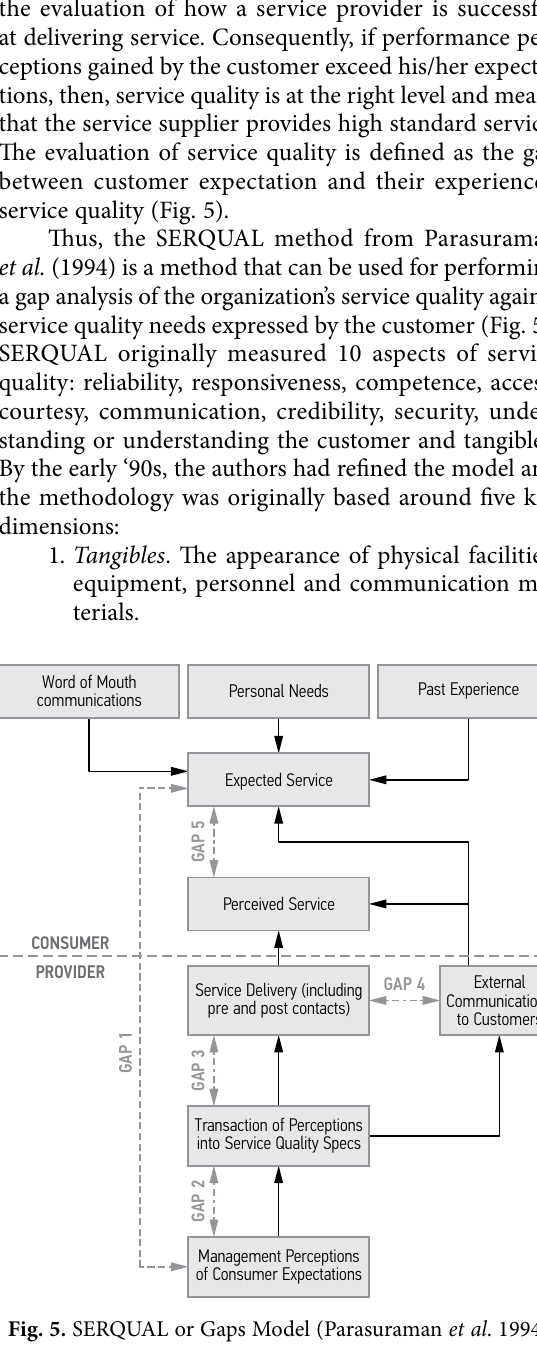
Fig. 5. SERQUAL or Gaps Model (Parasuraman et al .